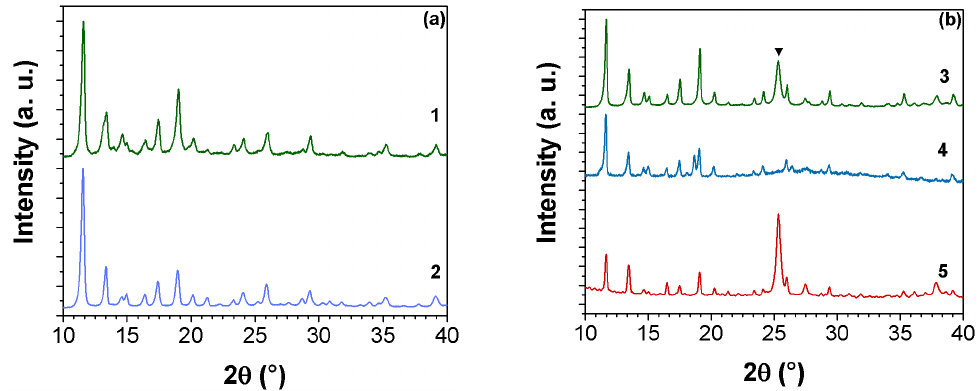
( b ) 50TiO 2 P25/com-HKUST-1 (3), 50TiO 2 ST/com-HKUST-1 (4), and 50TiO 2 P25/syn-HKUST-1 (5). ▼ ( b ) 50TiO 2 P25 / com-HKUST-1 (3), 50TiO 2 ST / com-HKUST-1 (4), and 50TiO 2 P25 / syn-HKUST-1 (5). denotes the peak corresponding to TiO 2 anatase. (cid:72) denotes the peak corresponding to TiO 2